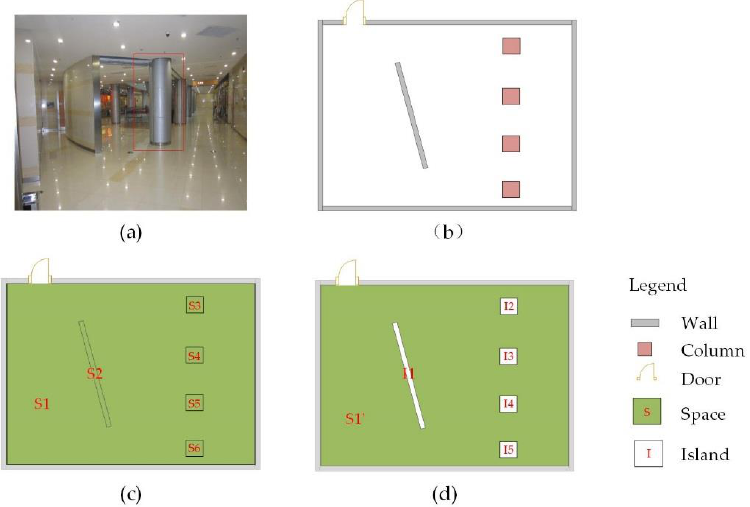
Figure 1. Complexity of large buildings. ( a ) Actual view and ( b ) plan of isolated components. ( c ) Indoor space results extracted using the search-loop method. S1 is the indoor space polygon obtained by the search-loop method. S2–S6 are the regions occupied by the isolated components of the building; ( d ) Actual results. I1–I5 are the internal islands of S1′.